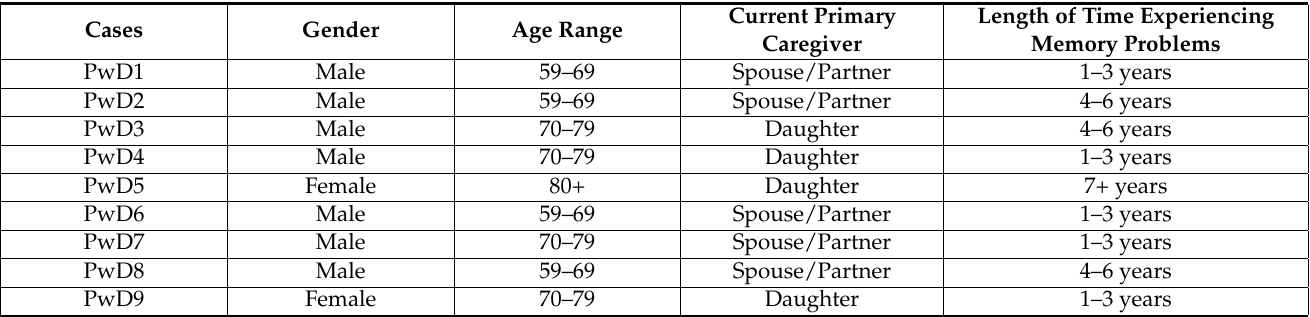
Table 2. People living with dementia (PwD) Demographic Characteristics.